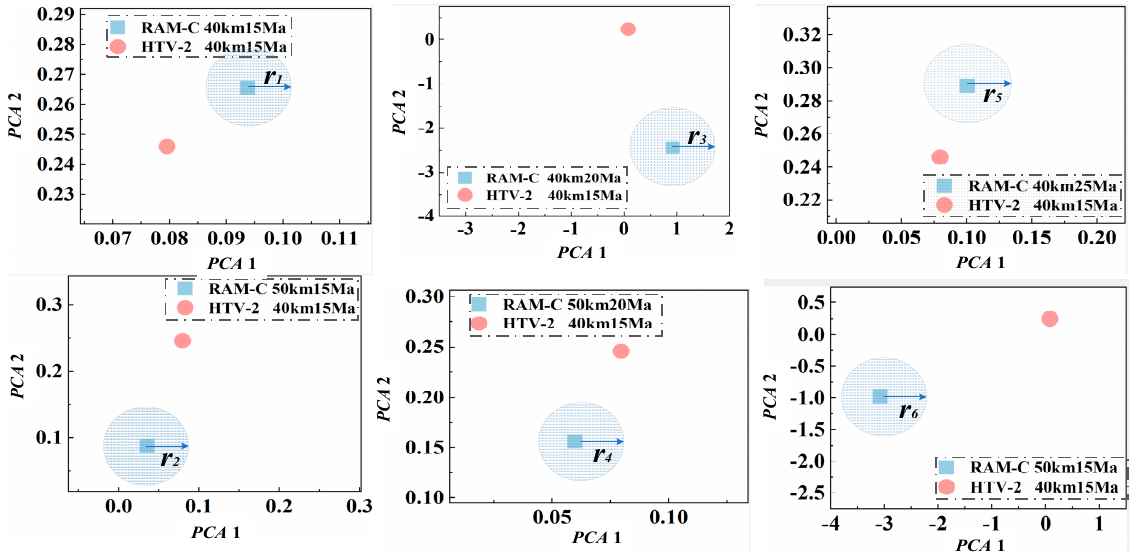
Figure 7. Local anomalies of a new class of HTs.